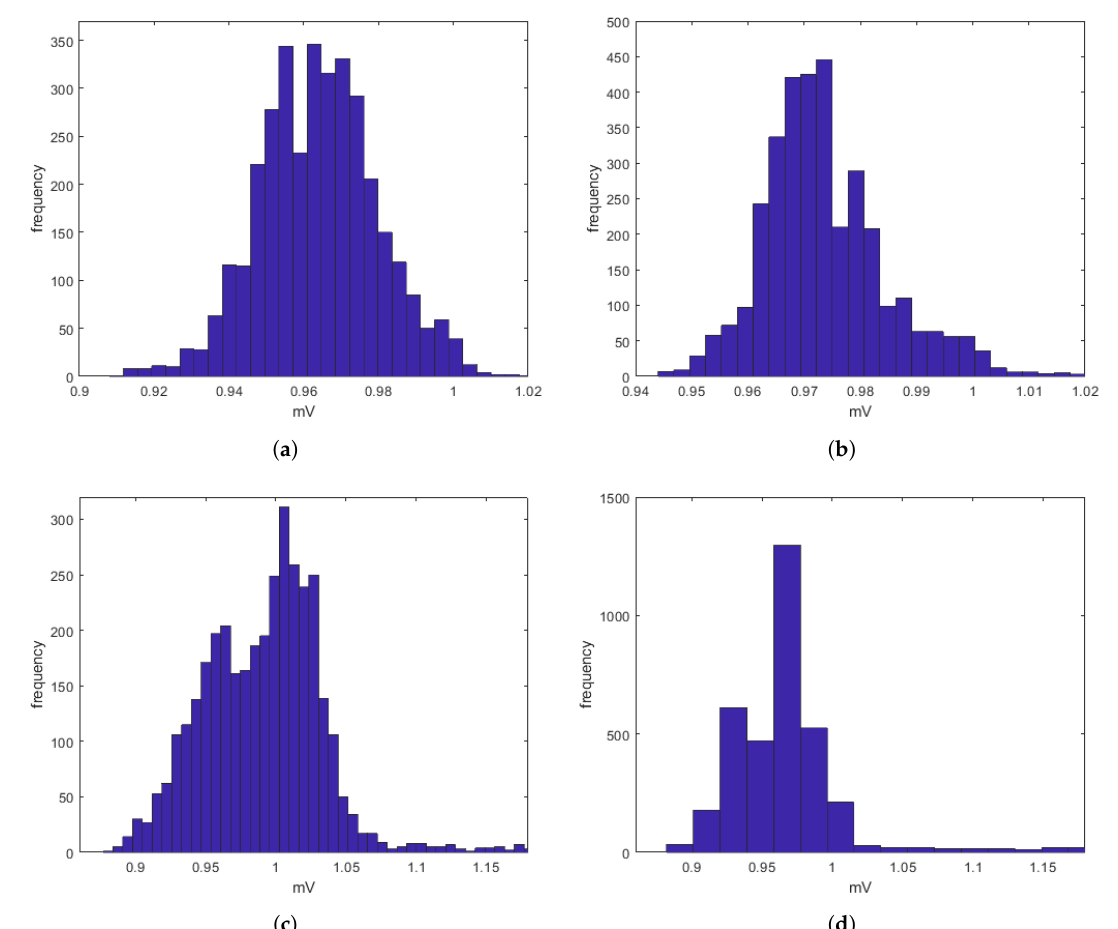
Figure 11. Histograms for typical ECG s characterized by ( a ) normal sinus rhythm, ( b ) atrial fibrillation, ( c ) atrial flutter, ( d ) premature ventricle